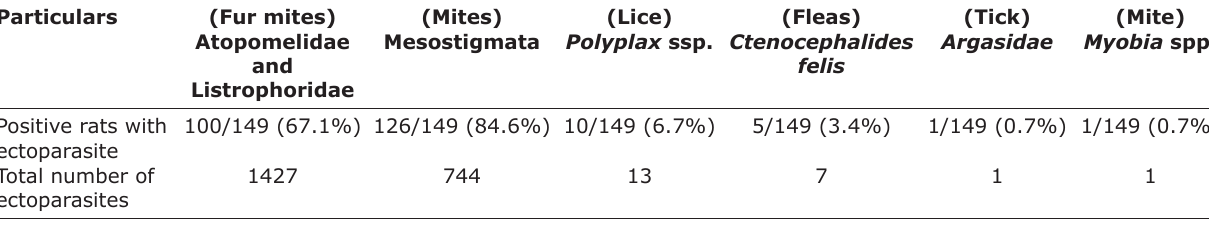
Table-1: Distribution of ectoparasites in brown rats from Grenada. Particulars